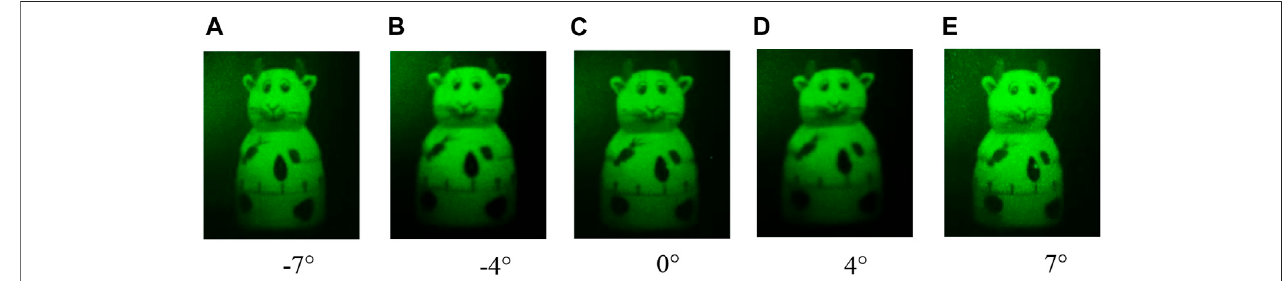
FIGURE 9 | Reconstructed images in the holographic near-eye display obtained from (A) left − 7 ° direction, (B) center 0 ° direction and (C) right 7 ° direction.